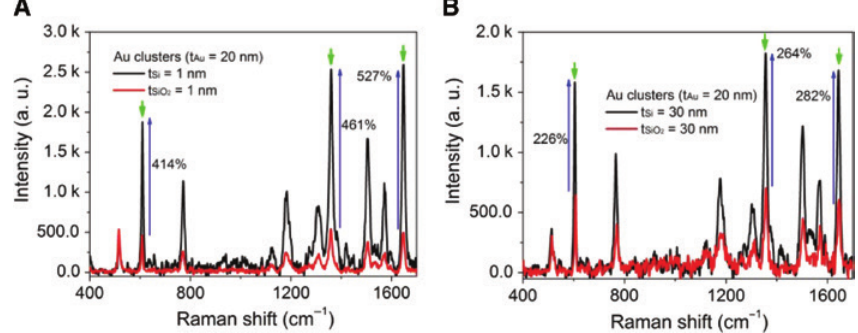
Figure 5: Surface-enhanced Raman scattering (SERS) performance for the Au clusters based substrate under different dielectric films. (A) (B) Comparison of the SERS spectral curves for the Au clusters under the same thicknesses of the Si and SiO